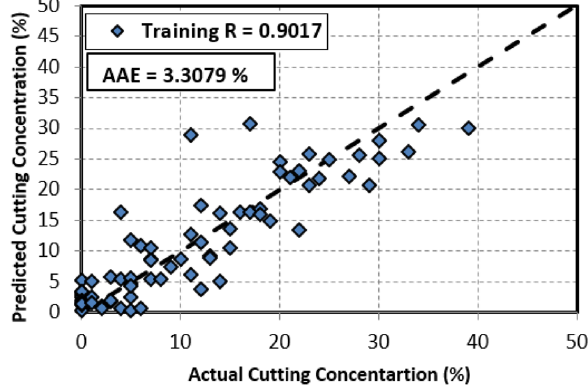
Fig. 7 BPNN-predicted versus actual (experimental) cutting concen- tration from network training